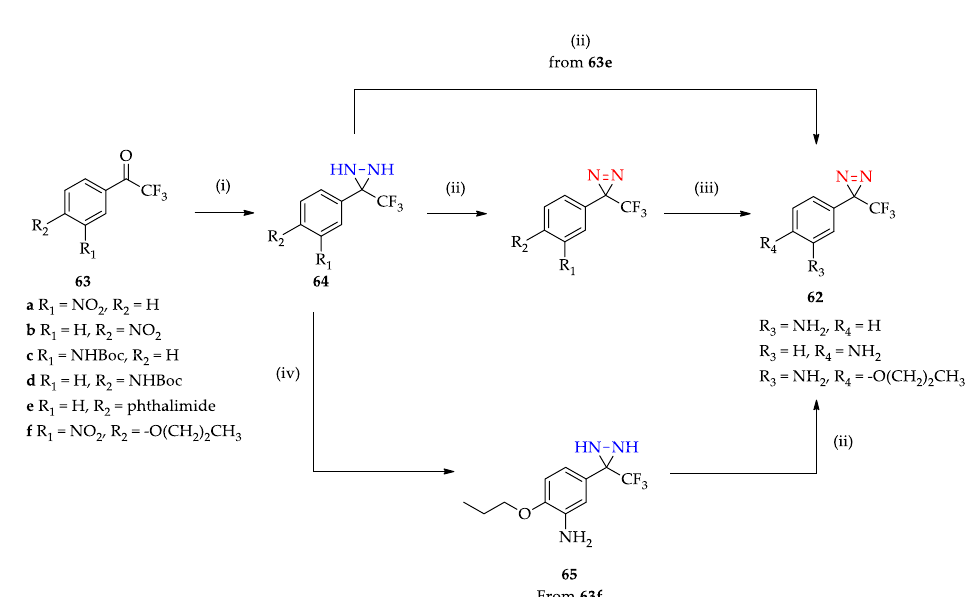
Figure 8. Improved method of NH 2 -substituted 3-phenyl-3-(trifluoromethyl)-3 H -diazirine 62 . Reagents: (i) 1. NH 2 OH-HCl, pyridine or EtOH; 2. TsCl, Et 3 N, acetone or DMAP; 3. NH 3 , Et 2 O or CH 2 Cl 2 ,